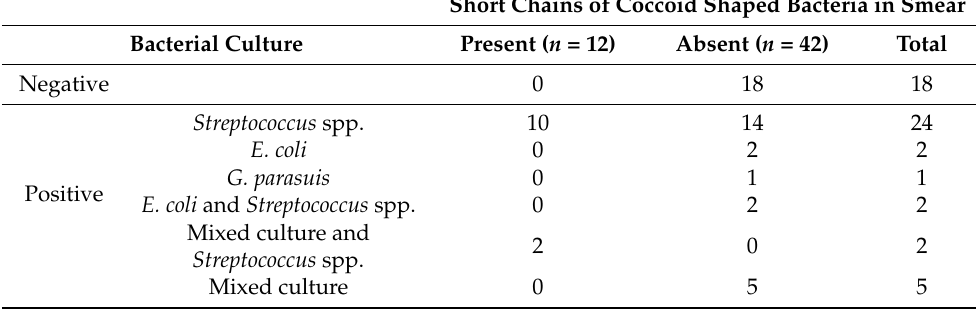
Table 2. Presence of short chains of coccoid-shaped bacteria in cytologic impression smears of the leptomeninges of pigs in relation to the results of bacterial culture of the leptomeninges. Short Chains of Coccoid Shaped Bacteria in Smear Bacterial Culture Present ( n = 12) Absent ( n = 42) Total Negative Streptococcus spp.